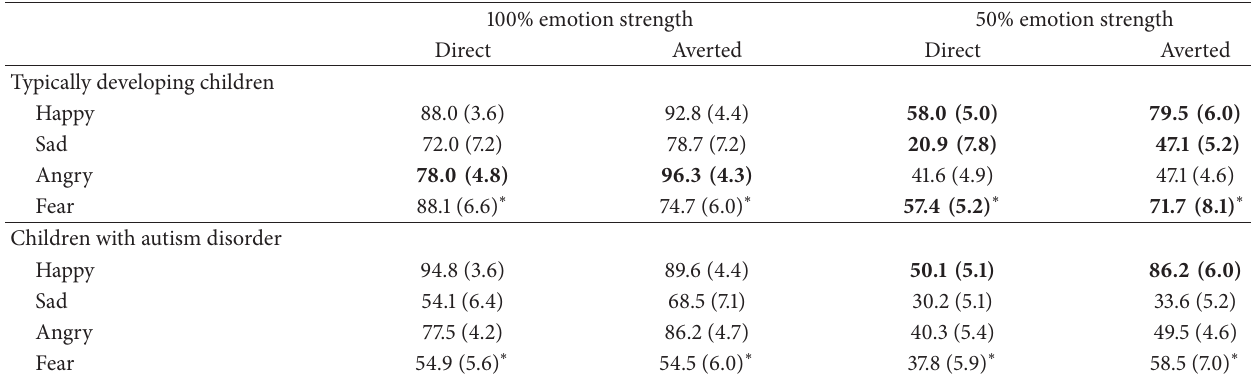
Table 1: Mean percent correct values for happy, sad, angry, and fear emotional expressions as a function of expression strength and eye gaze direction.